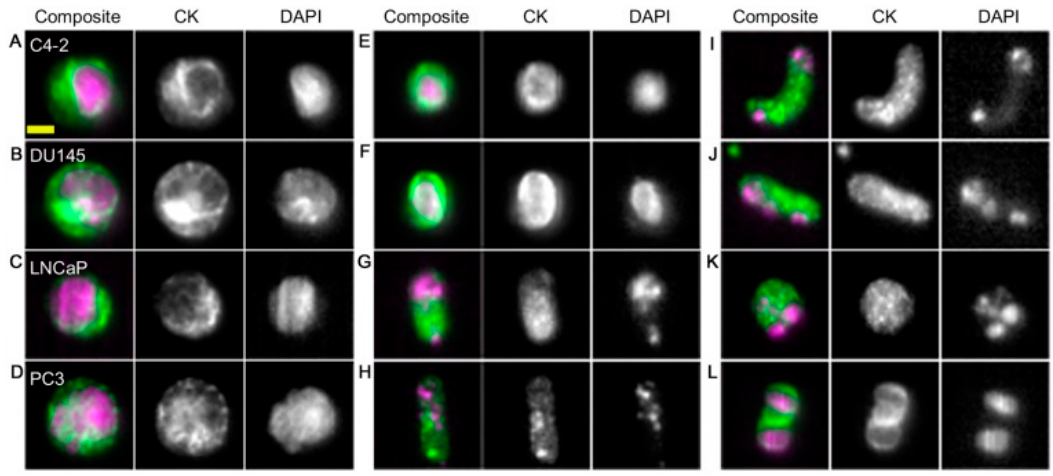
Figure 3. Images of cultured prostate cancer cell ( A–D ) and CTCs from prostate cancer patients ( E–L ) captured using the CellSearch system. (Reprinted from [35]).